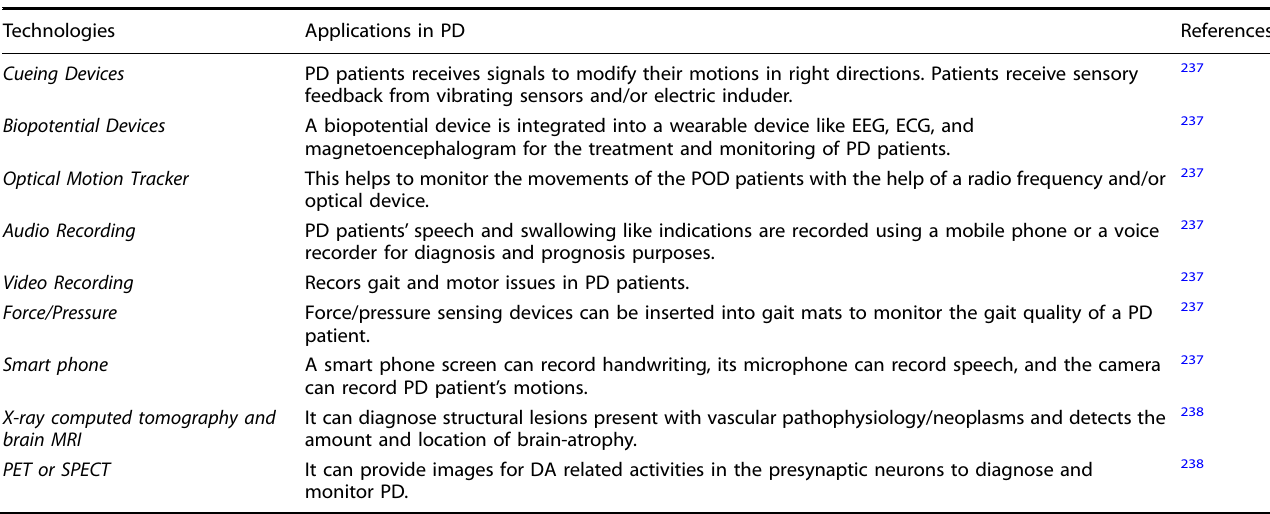
Table 3. Latest technologies used for detecting and neuroimaging